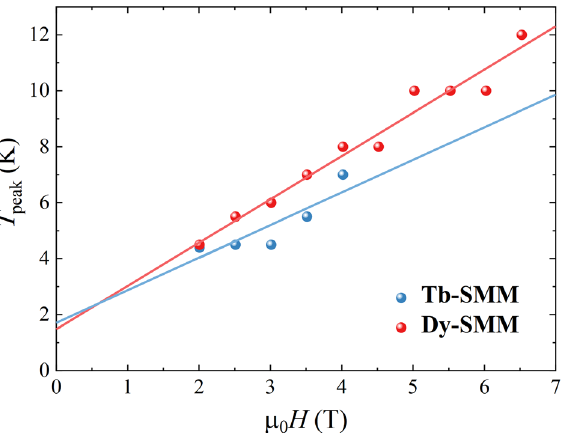
Figure 10. Field dependence of T peak for Tb-SMM and Dy-SMM . The solid lines are the best fits to the linear